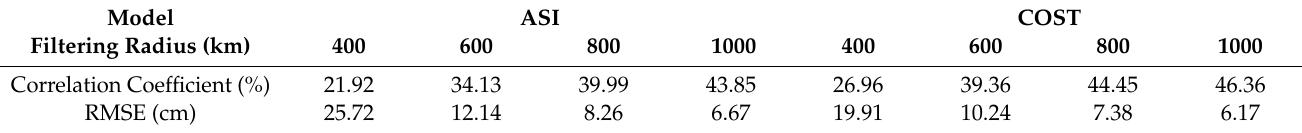
Table 6. The average results of Swarm-TWSC of different filtering radius compared with GRACE-TWSC in 26 basins. Model ASI COST Filtering Radius (km) 400 Correlation Coefficient (%)